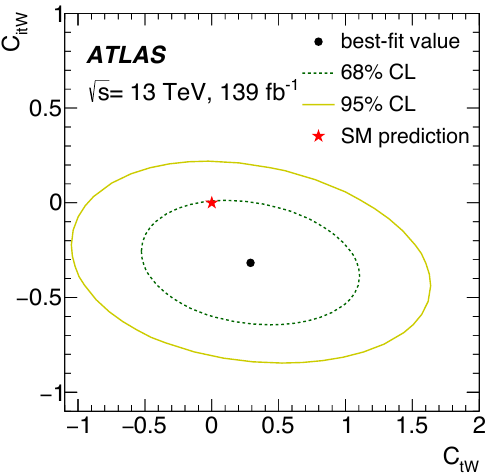
Figure 11 . The observed best-fit value (dot) for the Wilson coefficients C tW and C itW with the uncertainty contours at 68% CL (dashed) and 95% CL (solid). The CLs are ob- tained in a simultaneous fit of the two parameters using the prediction obtained with the MadGraph5_aMC@NLO+Pythia 8 generator. The red star indicates the SM